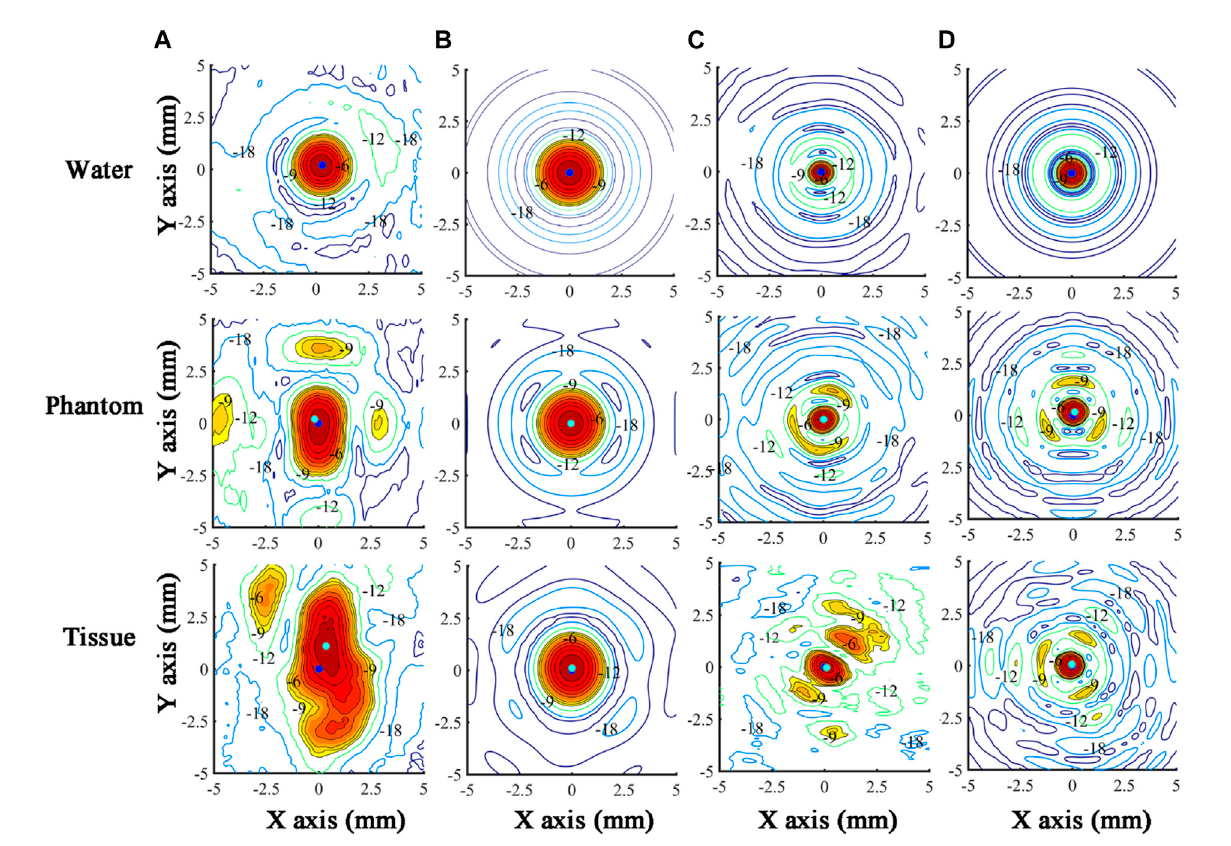
FIGURE 5 Ultrasound beam pro fi les in the radial (X-Y) focal plane of TW focusing in the (A) experiment and (B) simulation, and SW focusing in the (C) experiment and (D) simulation through water, Phantom, and Tissue. The acoustic focus and the origin of scanning coordinates (acoustic focus in water) are marked as cyan and blue dots, respectively. The regions with a normalized pressure larger than − 9 dB are in color.